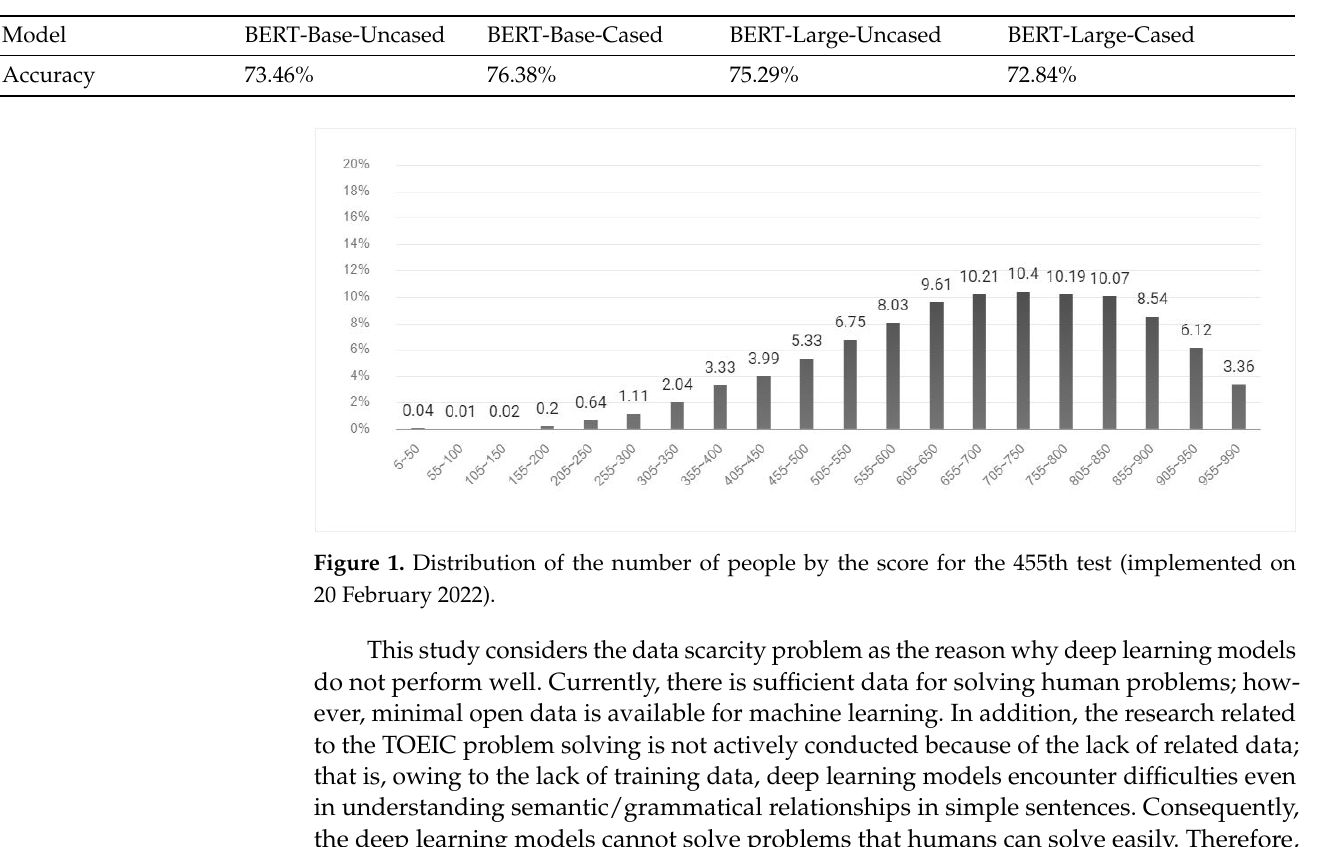
Table 1. Performance of TOEIC-BERT, an existing study that conducted experiments with a deep learning model for TOEIC Part 5.